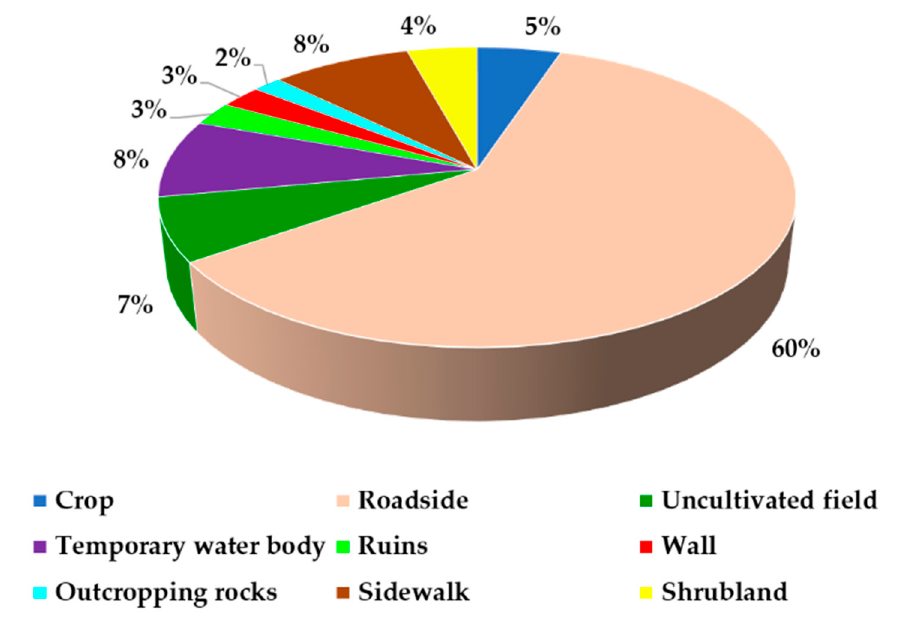
Figure 3. Habitats of the 34 alien taxa recorded for the flora of Calabria (Southern Italy, Europe).